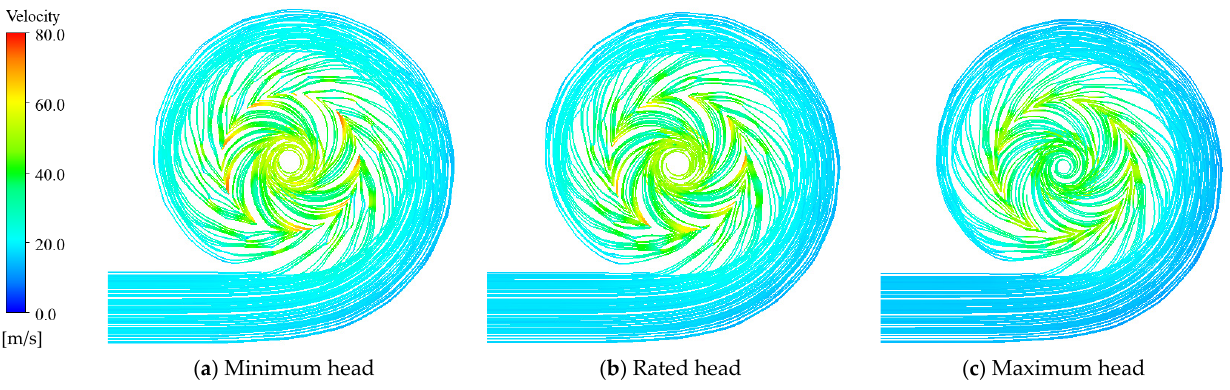
Figure 5. The streamline in the flow passage in three operating heads.